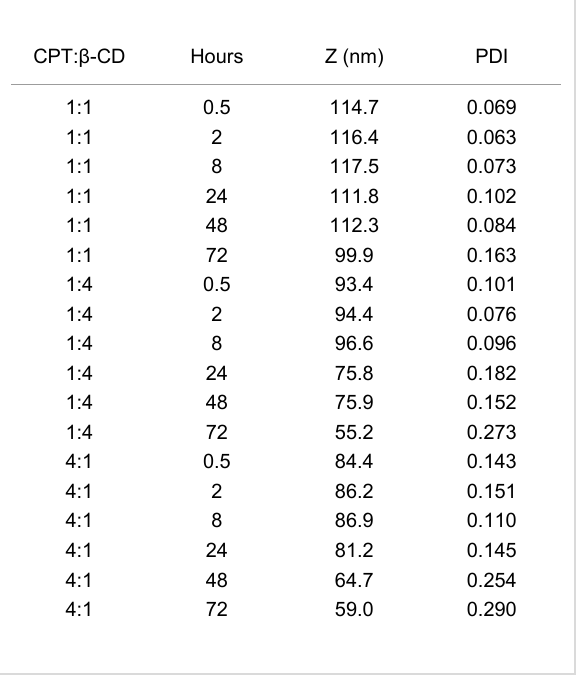
Table 3: Development in size over time of nanoparticles formed by association between D70GP-CPT2 and D70HP β -CD at different ratios, measured by dynamic light